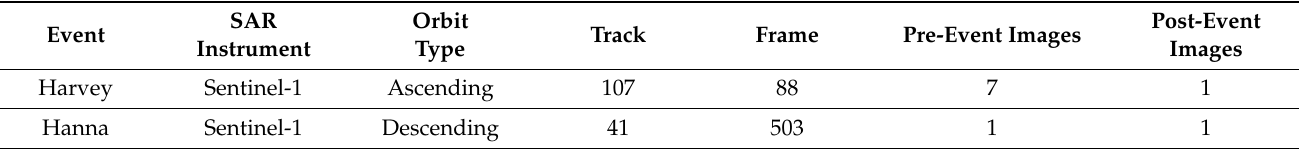
Table 2. Details of Sentinel-1 scenes used for flood